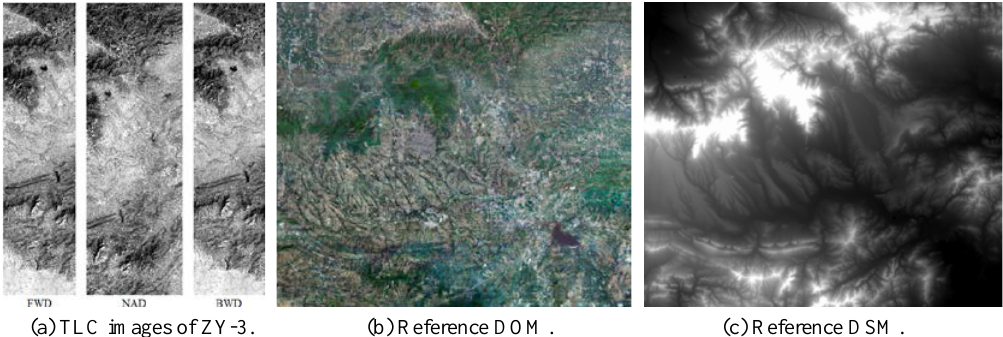
Figure 1. Essential data used for geometric